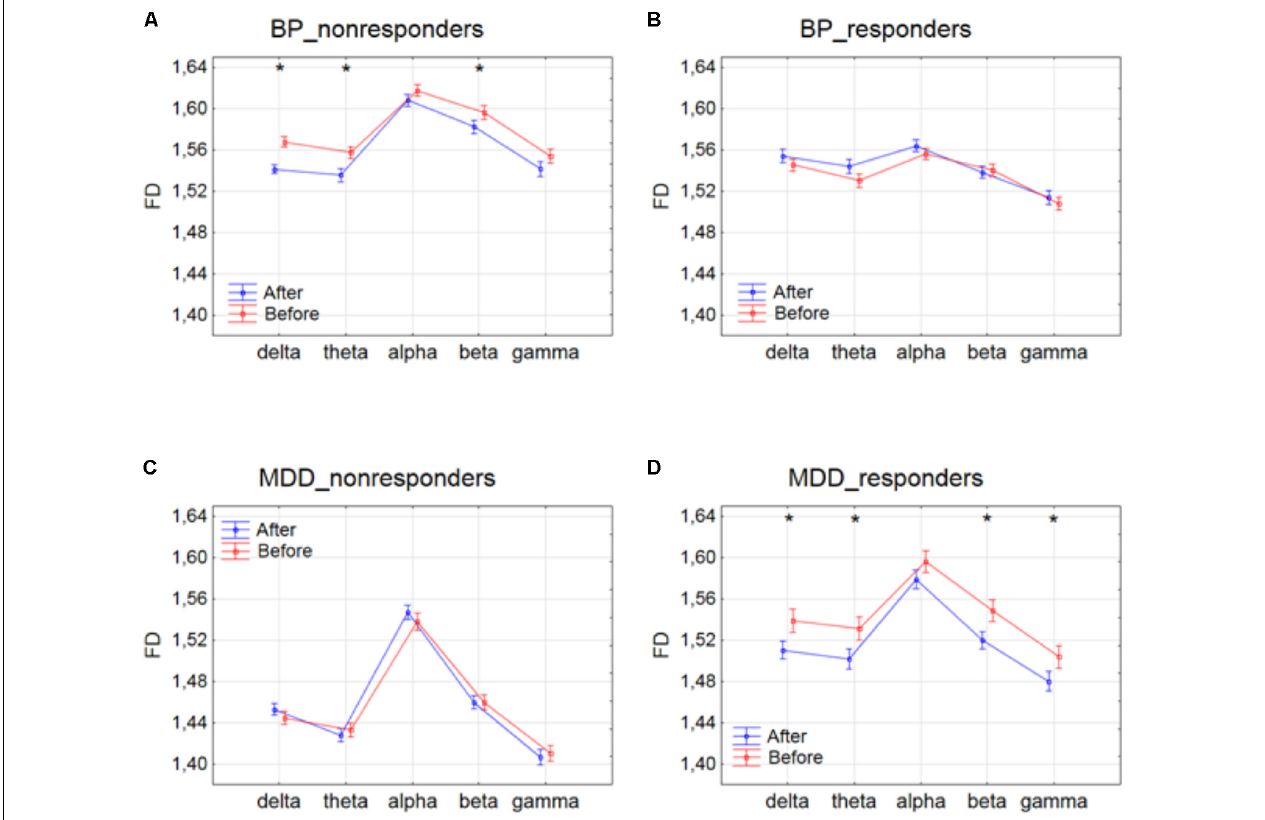
FIGURE 1 | Higuchi fractal dimension for BP_non-responders (A) , BP_responders (B) , MDD_non-responders (C) and MDD_responders (D) before and after stimulation in each of frequency bands. The interaction between factors CONDITION and BAND (all three sessions were included). Significant differences between conditions for the individual frequency bands, evaluated by post hoc Tukey HSD test, were marked with